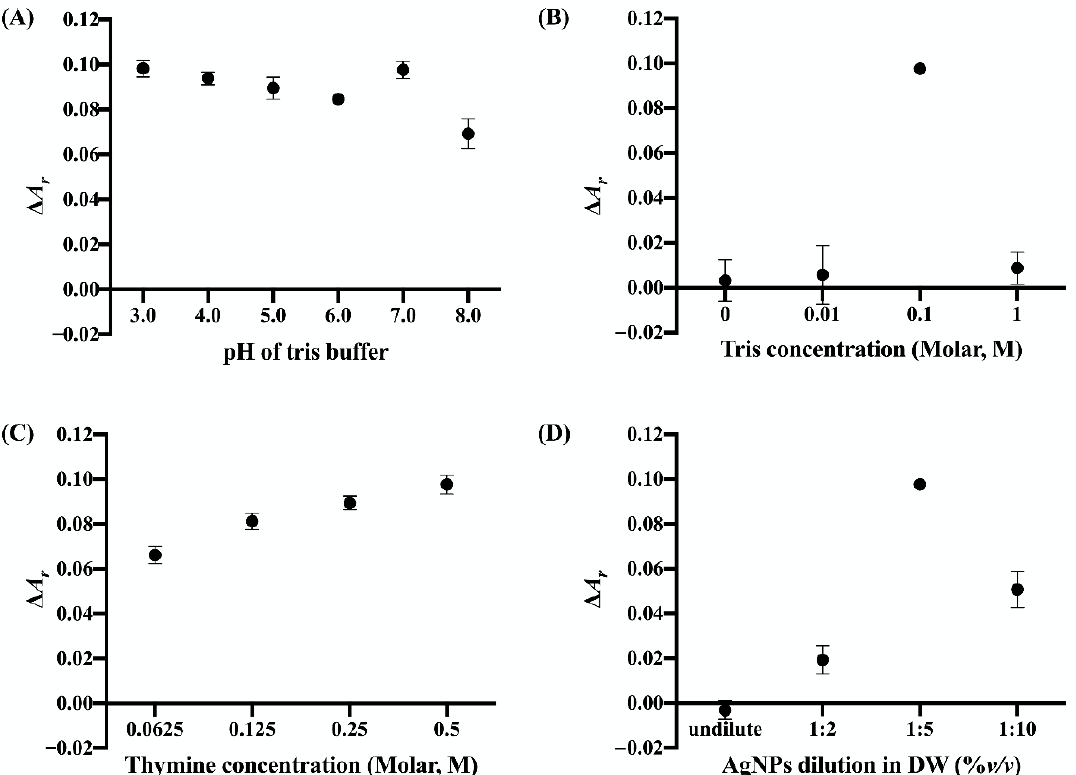
Figure 3. The plots of ∆ A r values against ( A ) pH of tris buffer (pH 3 − 8), ( B ) concentration of tris buffer (0, 0.01, 0.1, and 1 M), ( C ) concentration of thymine (0.0625, 0.125, 0.25, and 0.5 M), and ( D ) dilution ratio of AgNPs:DW (undilute, 1:2, 1:5, and 1:10).